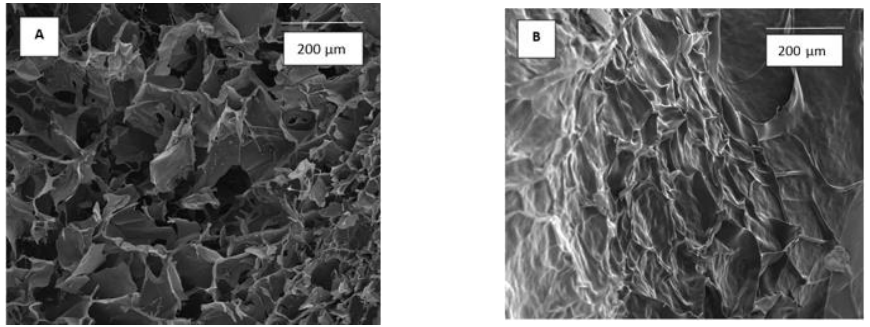
Figure 2. The structure of hydrogel without TA loading ( A ) and hydrogel loaded by immersion in tannic acid solution at 20% concentration ( B ); magnification 500 × .